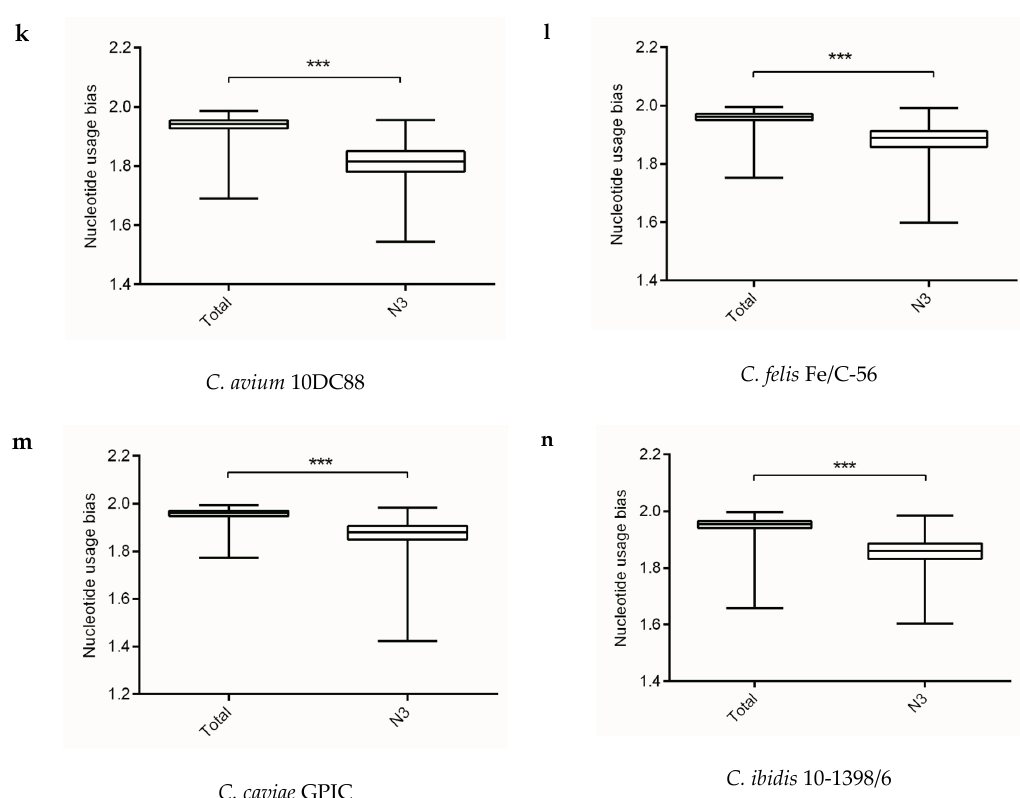
Figure 1. The overall codon usage bias and codon usage bias at the third codon position at gene levels of the Chlamydia spp. ( a ) C. trachomatis L2/25567R, ( b ) C. trachomatis A-HAR-13, ( c ) C. trachomatis